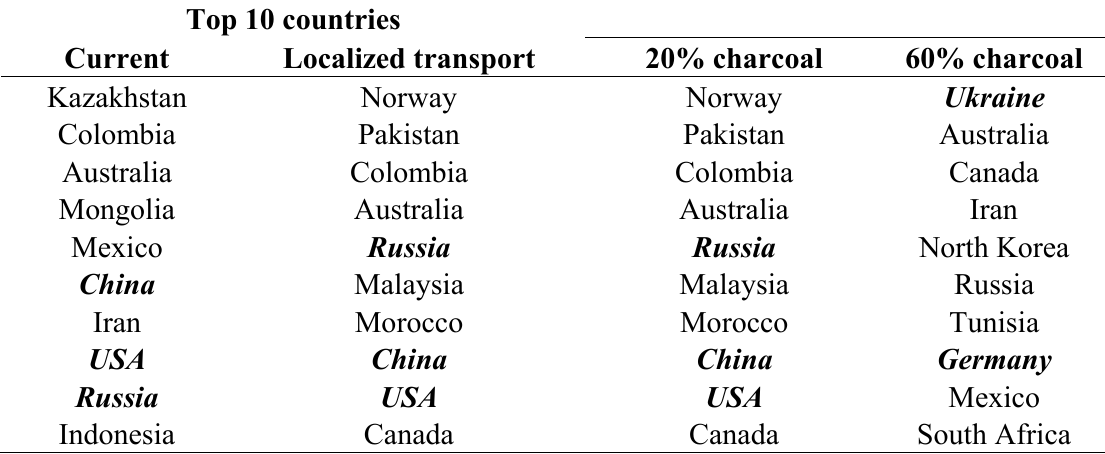
Table 9. Top countries for the production of steel, based on the radius of reduction (current major producers highlighted).